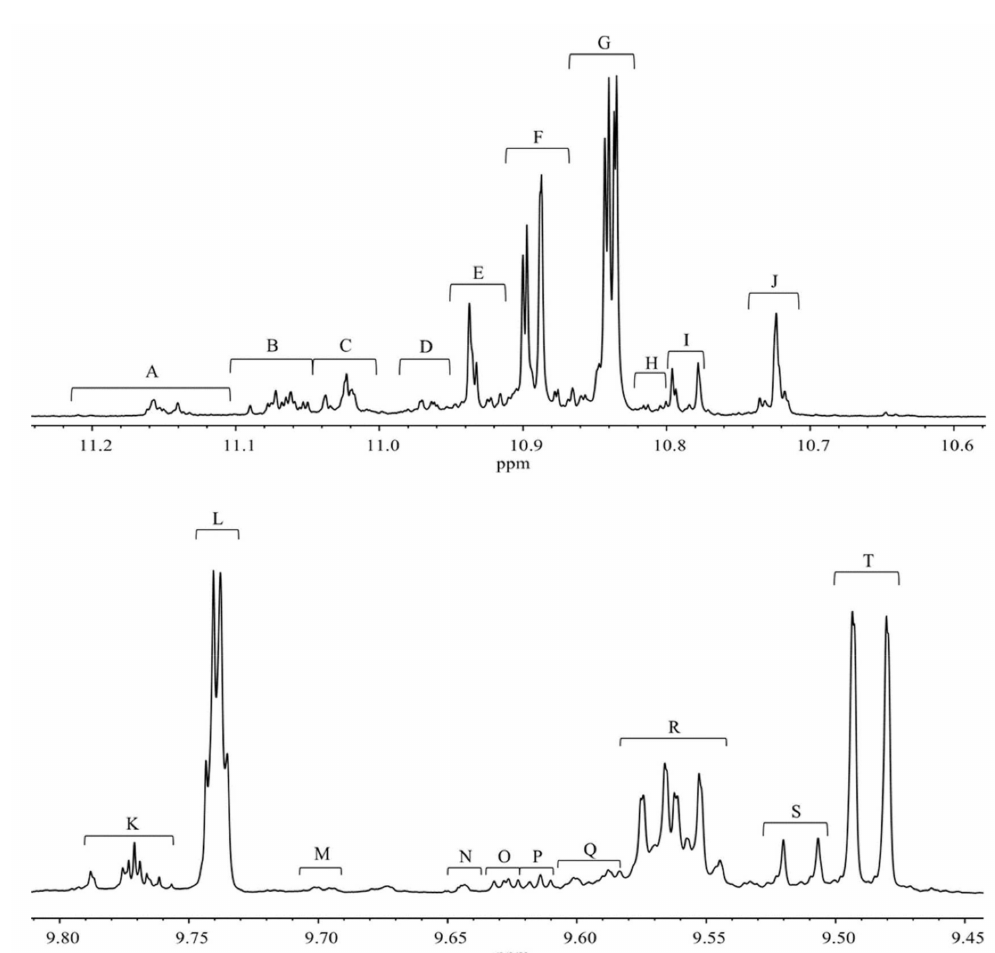
Figure 35. 1 H-NMR spectra (700 MHz) obtained with band-selective excitation, with assignment coding, according to Table 5. The sample contained 25% oxidized oil in 75% 5:1 CDCl 3 /DMSO- d 6 . Top: hydroperoxide region ( δ 11.24 − 10.57 ppm); Bottom: aldehyde region ( δ 9.81 − 9.44 ppm). Reprinted with permission from [135]. Copyright 2018, American Chemical